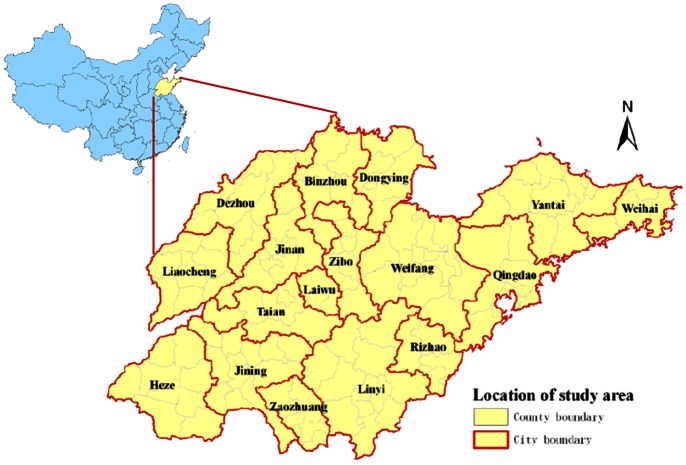
The location of study area, Shandong Province in China.